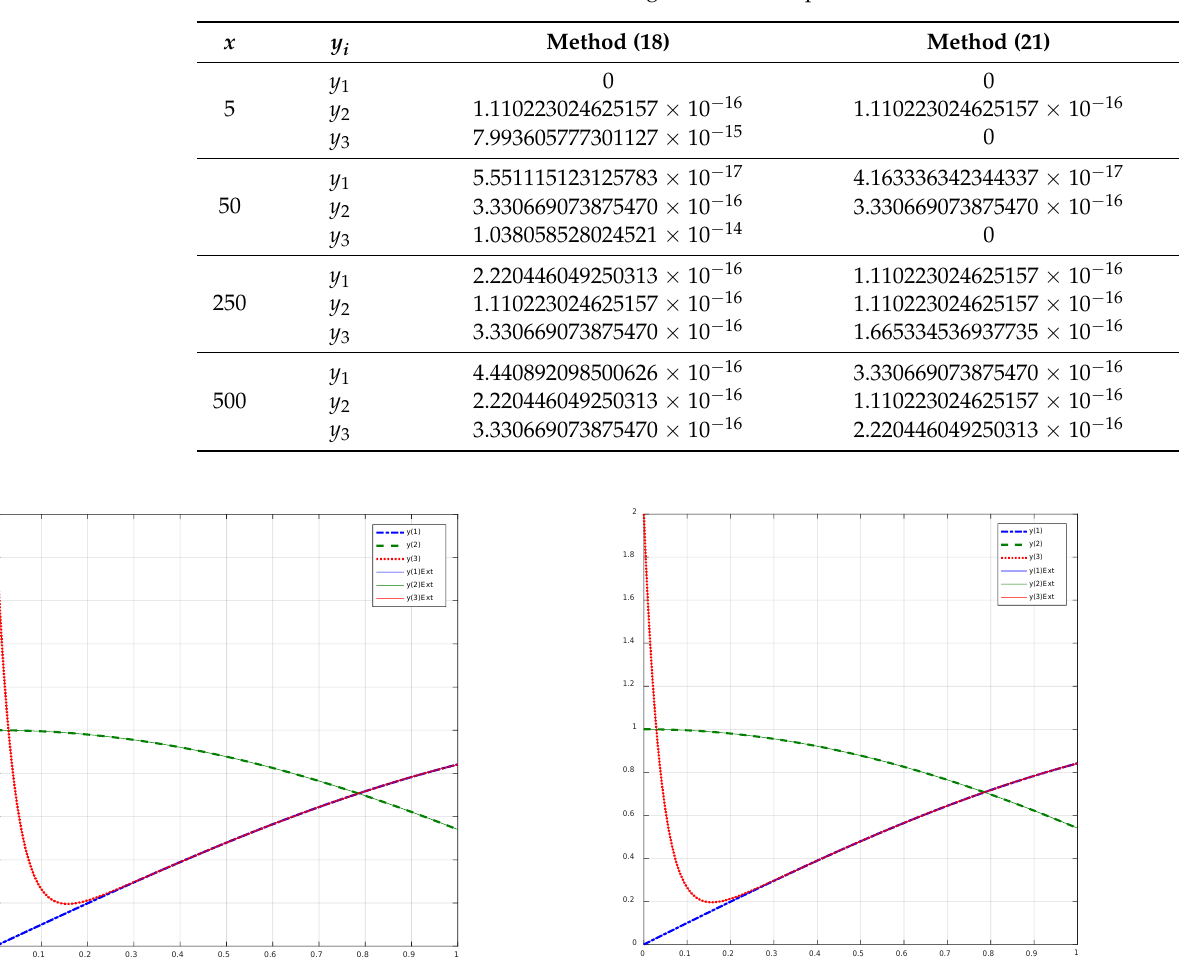
Table 3. Absolute errors in the numerical integration of Example 2.